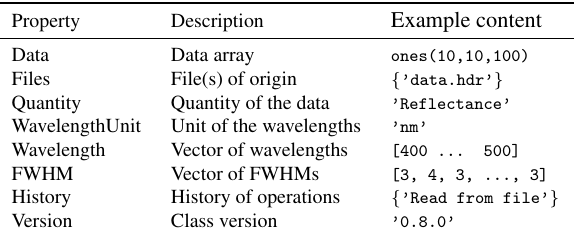
Table 1. Data type object